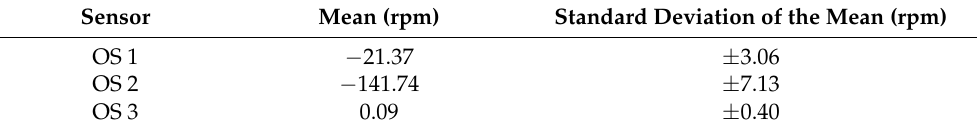
Figure 8. Histogram that represents the deviation in the calculated instantaneous speed (OS 3) with respect to the OPR reference speed (4945 rpm). Table 3. Summary of the statistical analysis corresponding to the data shown graphically in Figure 8. The summary shows the results corresponding to OS 1, OS 2 and OS 3. Nominal speed of the working point: 4945